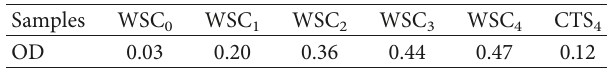
Table 3: OD of solution determined by reducing power of WSC samples and CTS 4 .